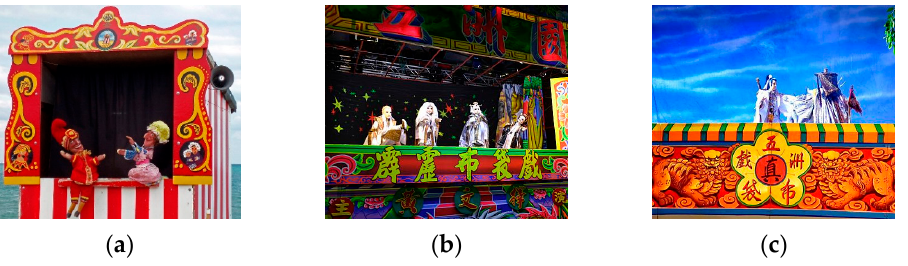
Figure 1. Three examples of puppetry. ( a ) British traditional hand puppet show: “Punch and Judy” [1]. ( b ) A Taiwanese glove puppet show: “Thunderbolt Fantasy: Sword Seekers” [2]. ( c ) Another Taiwanese glove puppet show: “Great Confucian Hero of Yunzhou: Wulin Great Storm” [3].